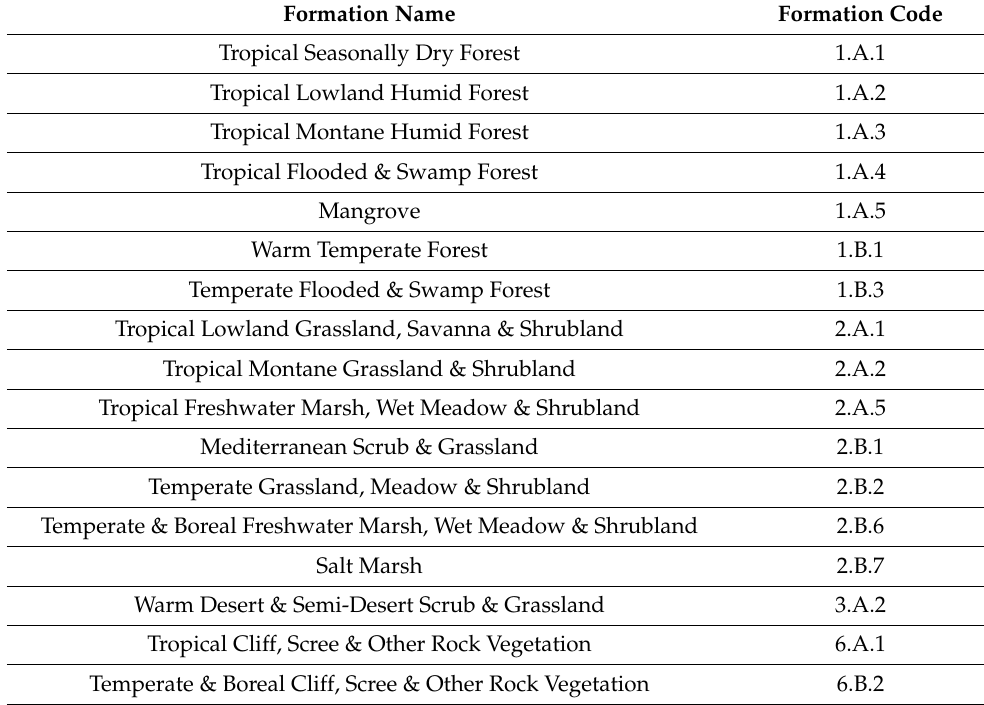
Figure 2. Map of the study region (WGS84 geographic coordinate system); occurrence records of the target Chaetocnema species are overlaid on a raster map (90 m cell resolution) representing vegetation formations of the Republic of South Africa, Lesotho and Swaziland. The name of the vegetation formation corresponding to each of the alphanumerical codes in the legend are reported in Table 1. Table 1. Vegetation formations of Africa and corresponding alphanumeric